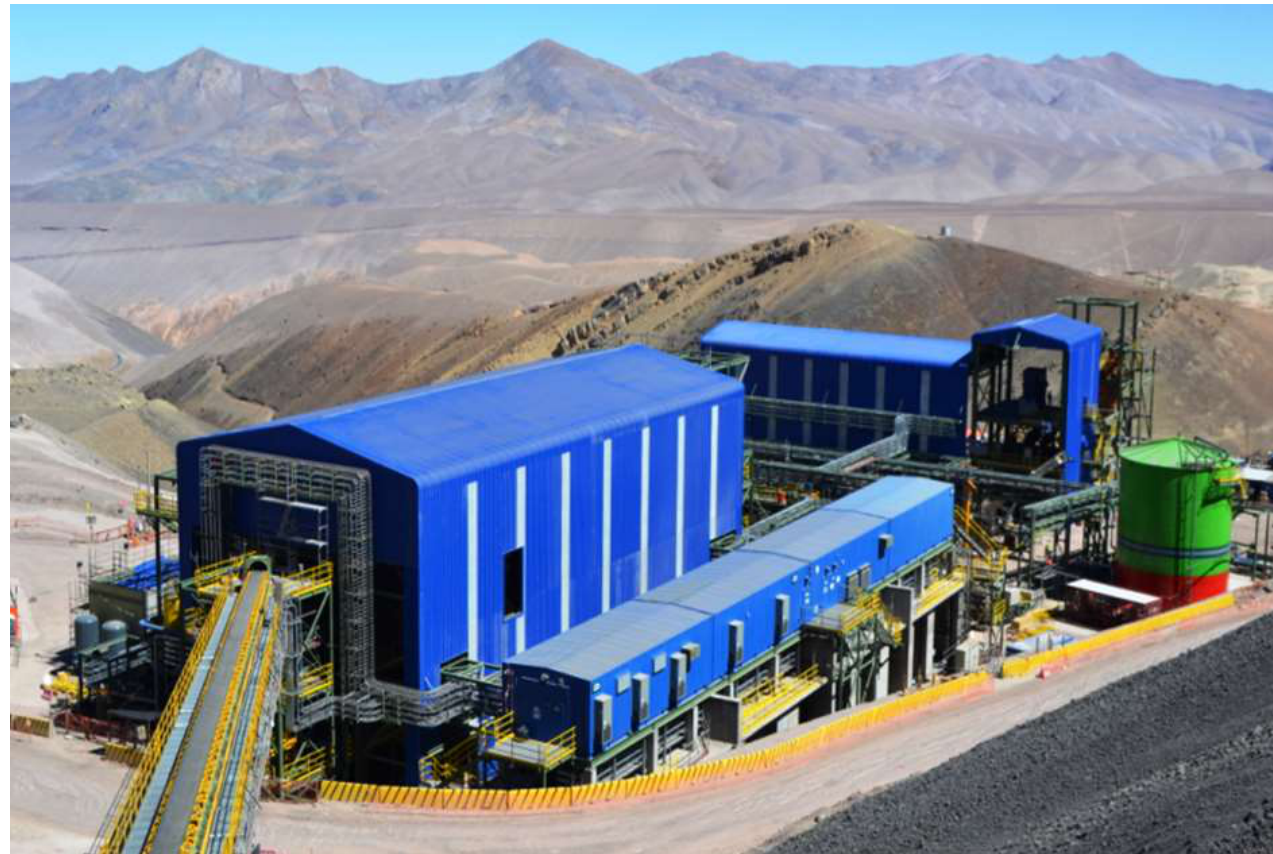
Figure 52. Potrerillos Filtered Tailings Storage Stockpile Facility [18,69].